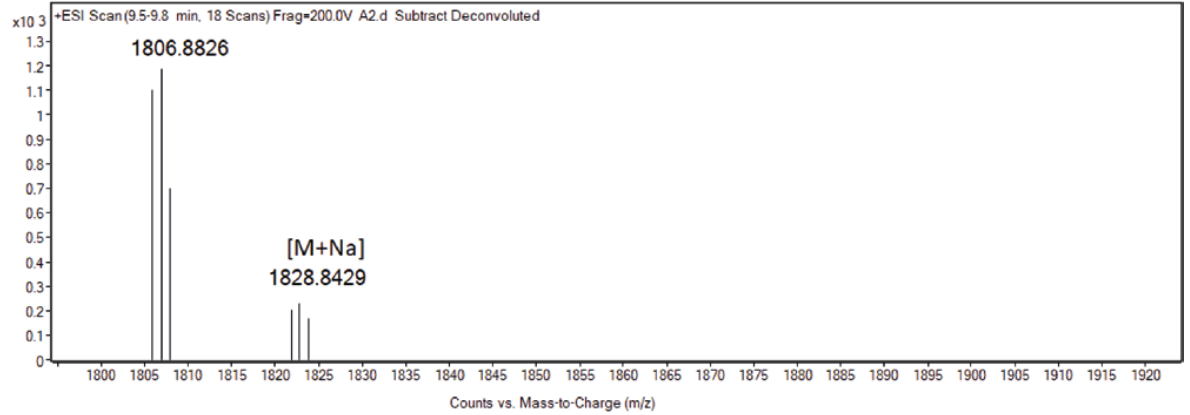
Figure 2. Electrospray ionization time-of-flight (ESI-TOF) deconvoluted mass spectrum of the sample after 2 h of incubation.